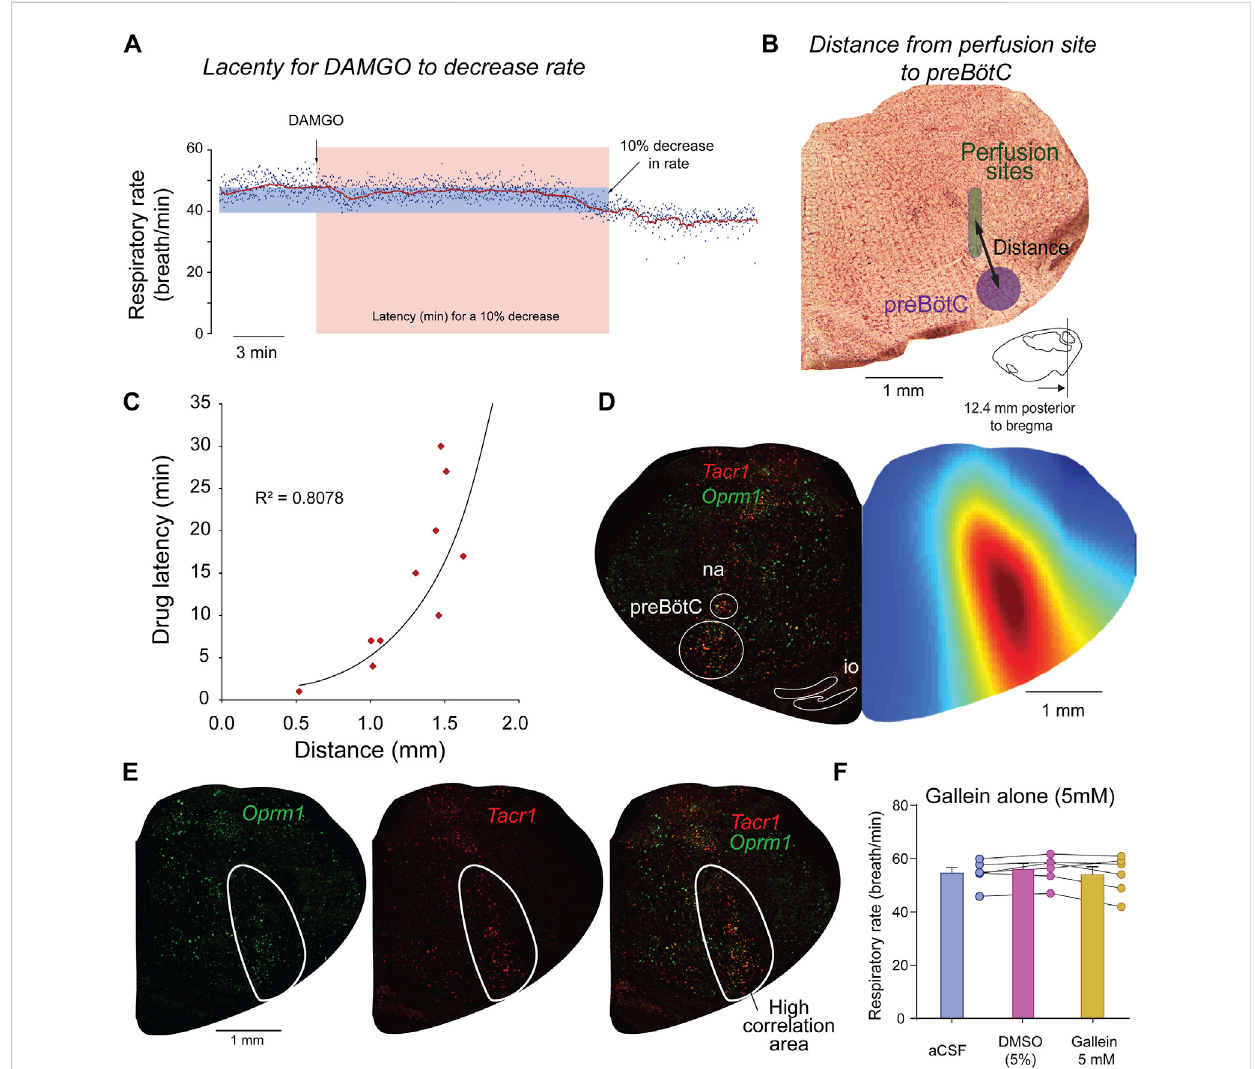
FIGURE 3 Site of action of DAMGO and gallein overlaps with Oprm1 and Tacr1 expressions. To determine the brainstem region where DAMGO is acting, we correlatedthelatencyforDAMGOtodecreaserespiratoryratewiththedistancesfromthepreBötCtothemicroperfusionsites.Thelatencyinminutesfor a 10% decrease from baseline respiratory rate was calculated for each experiment (A) . For each corresponding experiment, the distance from the microperfusion site (indicated in green) to the center of the preBötC was calculated (B) . The coordinates for the preBötC are 12.4 mm posterior, 6 mmventral,and2.0lateraltoBregma.Asigni fi cantexponentialcorrelationwasfoundbetweendruglatenciesanddistances(R 2 =0.8078, p < 0.001 ,n= 10 experiments) (C) . To determine whether other sites in the brainstem may mediate some of the respiratory depression induced by DAMGO, we generated a color map of the brainstem section where each pixel (every 50 µm) corresponds to a coef fi cient of correlation (blue equals low correlation, whereasredhighcorrelation).Foreachsetofcoordinatesinthesection,thecorrelationcoef fi cientwascalculatedusinglatenciesandthedistancesfrom the microperfusion sites to the coordinatesof thecorresponding pixel. This correlation map shows that the area of thebrainstem where the correlations are the highest corresponds to the region of the preBötC (D) . The highly signi fi cant part of the correlation map (R 2 > 0.5) overlapped with cells labelled with Oprm1 and Tacr1 (E) . Control experiments were performed with microperfusion in the preBötC of aCSF, arti fi cial spinal fl uid, DMSO, dimethyl sulfoxide (5%) or gallein (5 mM) alone. See Methods for additional information on correlation maps as well as previous studies using this approach (Montandon et al., 2011; Montandon et al.,